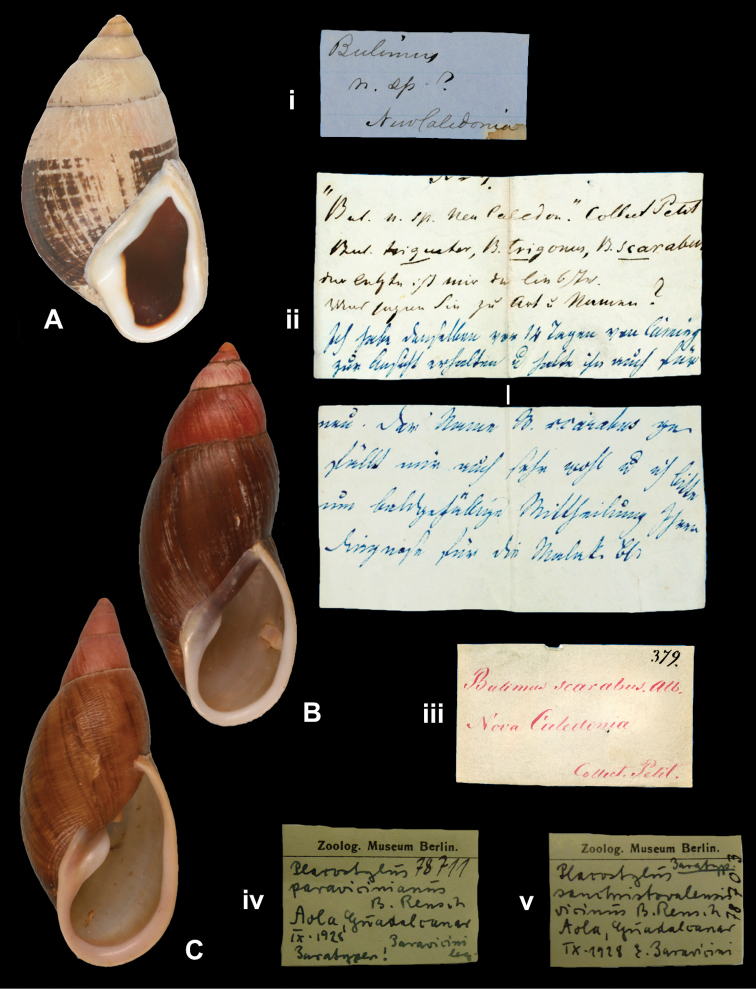
A, i–iii
Placostylus scarabus (Albers, 1854), syntype ZMB 101820 (H = 53.8) Photo: C. Zorn B, iv
Aspastus paravicinianus (B. Rensch, 1934), paratype ZMB 78711 (H = 66.6) C, v
Eumecostylus vicinus (B. Rensch, 1934), paratype ZMB 78702 (H = 63.6).